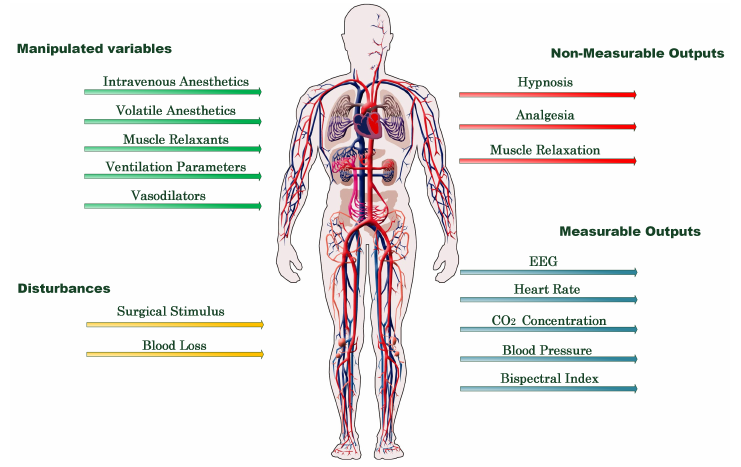
Figure 1. Input–output variables in anesthesia.